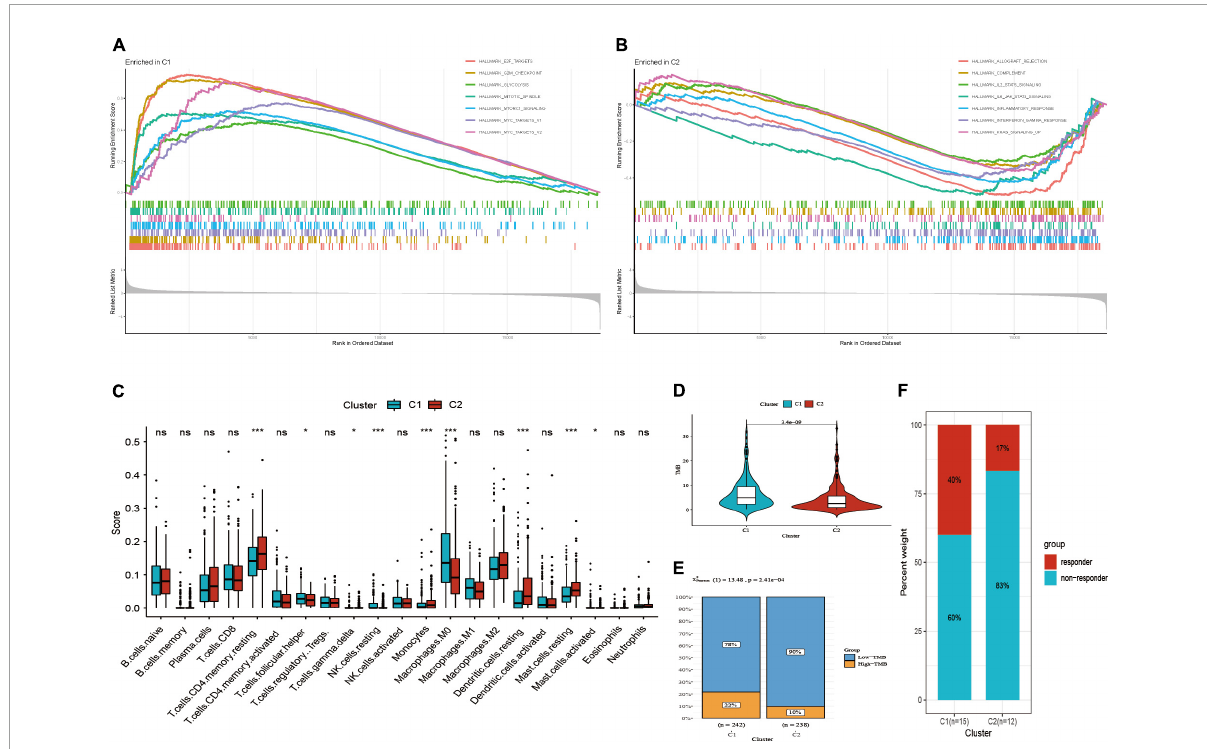
FIGURE4 Functional pathways, immune infiltration and TMB analysis. (A) Functional pathways in C1 subtype. (B) Functional pathways in C2 subtype. (C) Comparison of immune score. (D) Comparison of TMB score. (E) Distribution of low and high TMB between two subtypes. (F) Distribution of response to immunotherapy between two subtypes in GSE135222. * P < 0.05; *** P < 0.001; ns: not